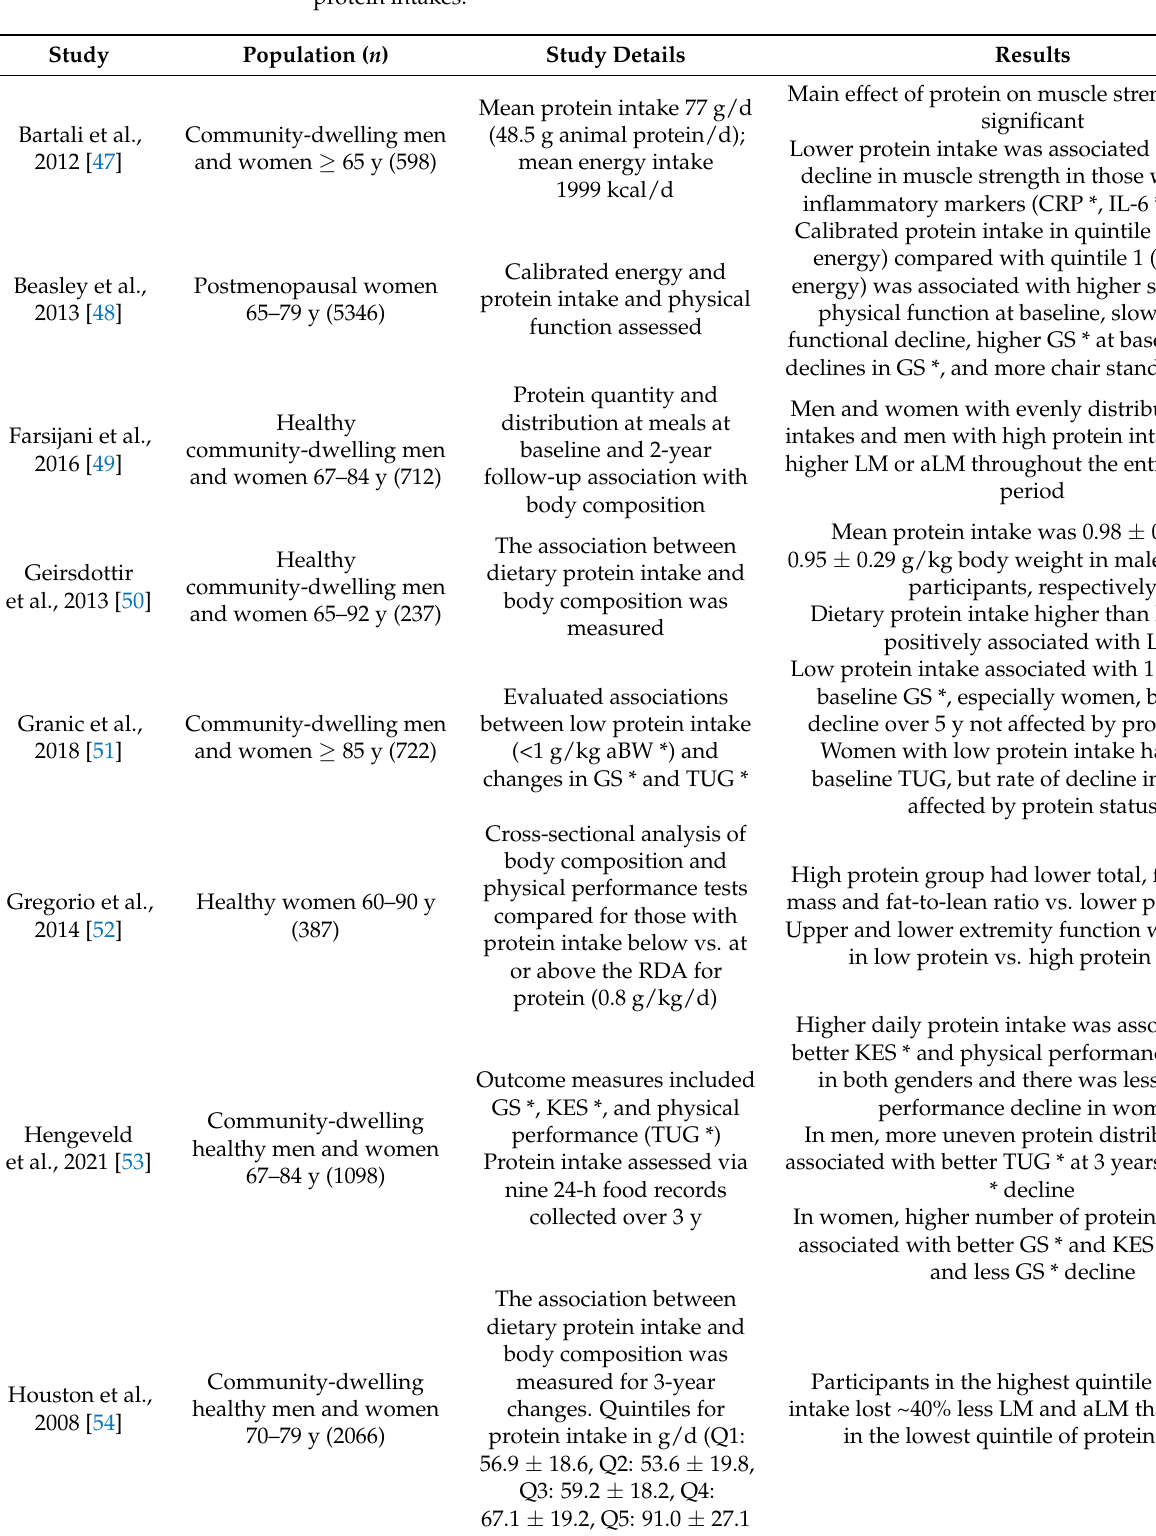
Table 2. Studies reporting different health or functional/performance benefits of higher vs. lower protein